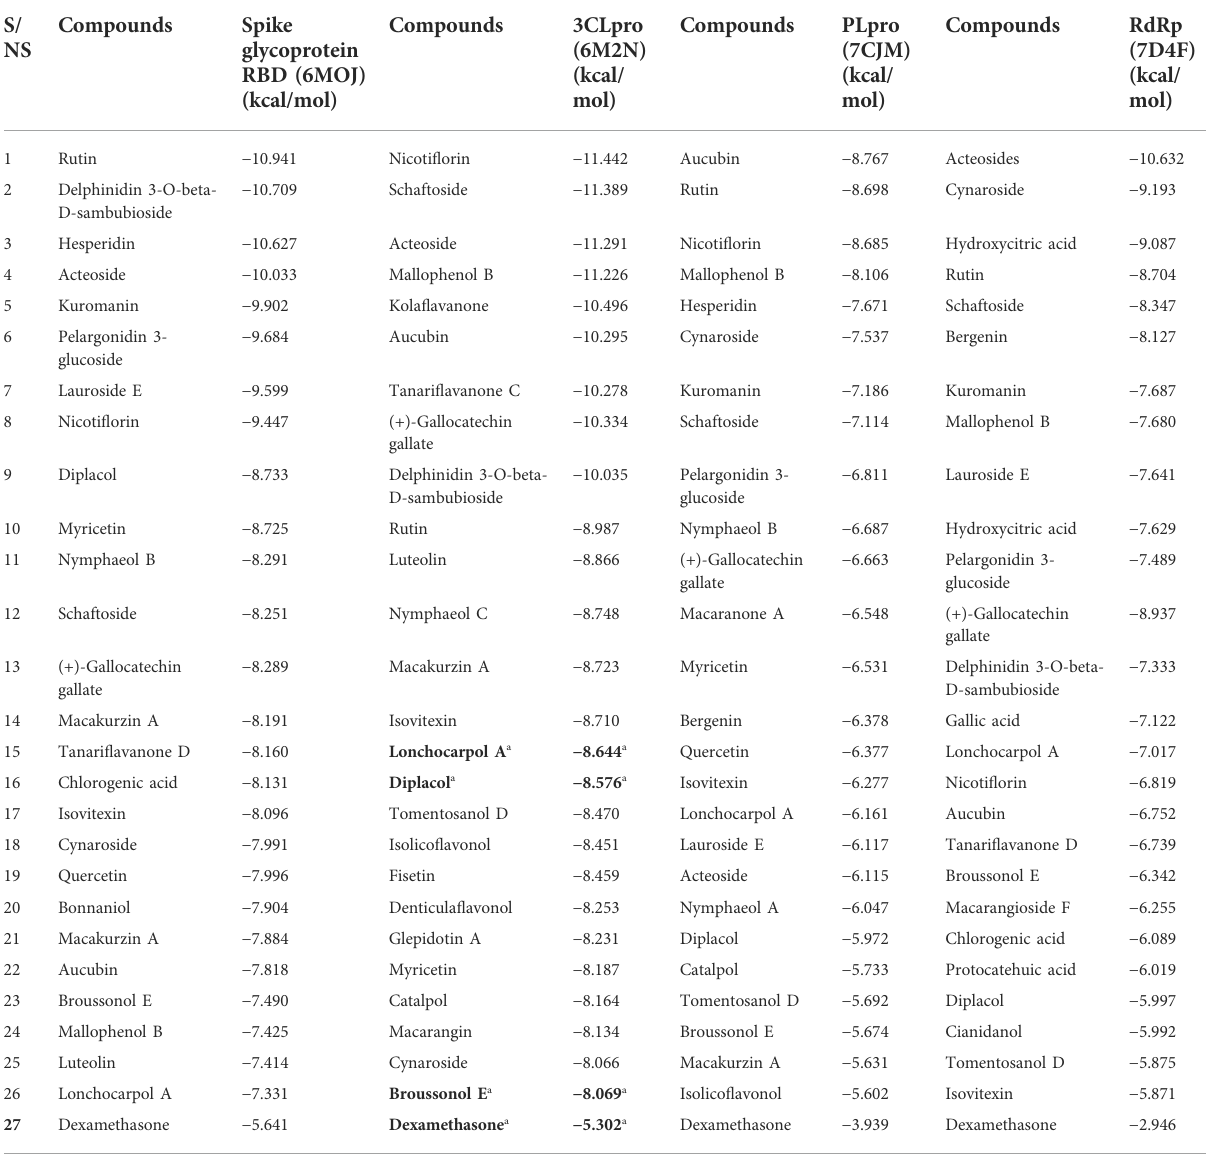
TABLE 5 Binding energy of compounds library against the SARS-CoV-2 therapeutic